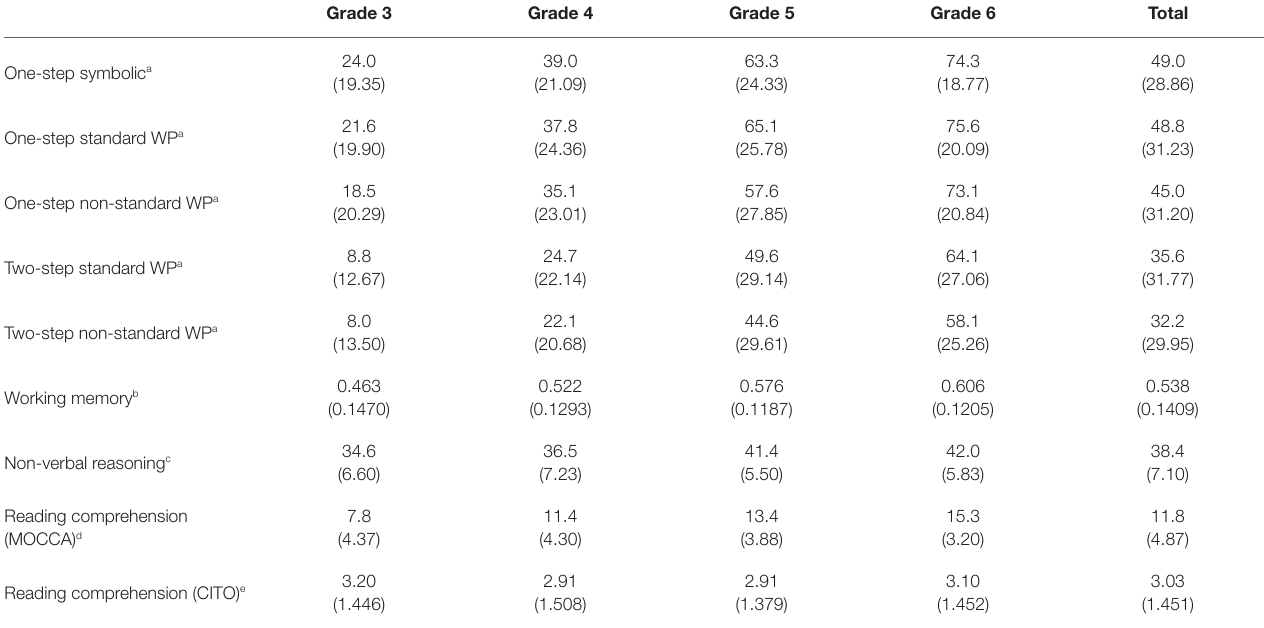
TABLE 2 | Descriptive statistics of the measures: Means and SD’s (between brackets).